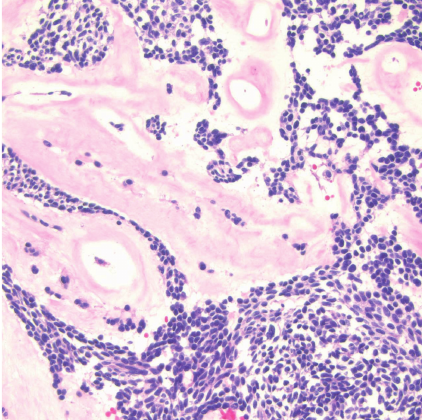
Figure 4: High power microscopic image demonstrating dense hyalinized stroma suggestive of precursor glomus tumor (Hema- toxylin and Eosin, 400x).